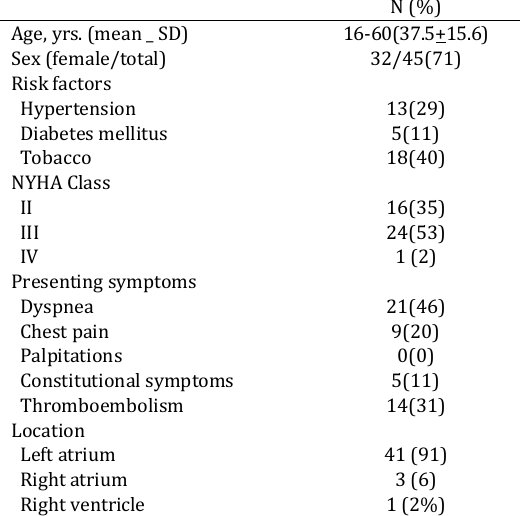
Table 1. Demographic characteristics of the